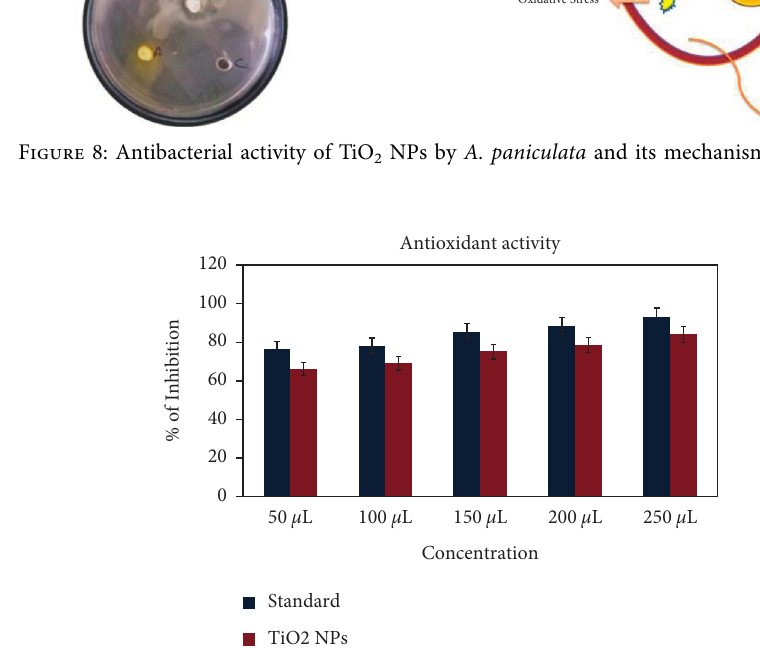
2 NPs by A. paniculata